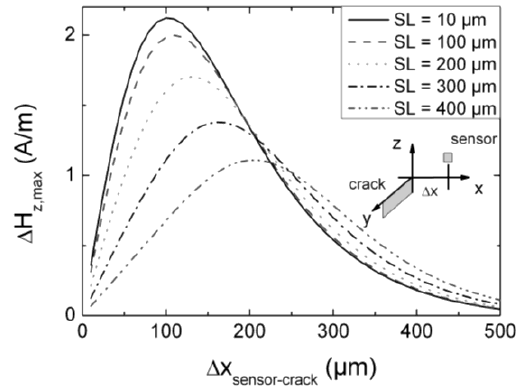
Figure 7. Simulations for the case that the surface normal of the sensor array is aligned parallel to the defect (see scheme inside of the diagram). The scanning direction is along the defect in y -direction. The diagram shows the maximum field difference Δ H sensor element as a function of the distance Δ x between sensor and defect for several SL . The baseline BL was 250 µm, LO = 150 µm and SH = 50